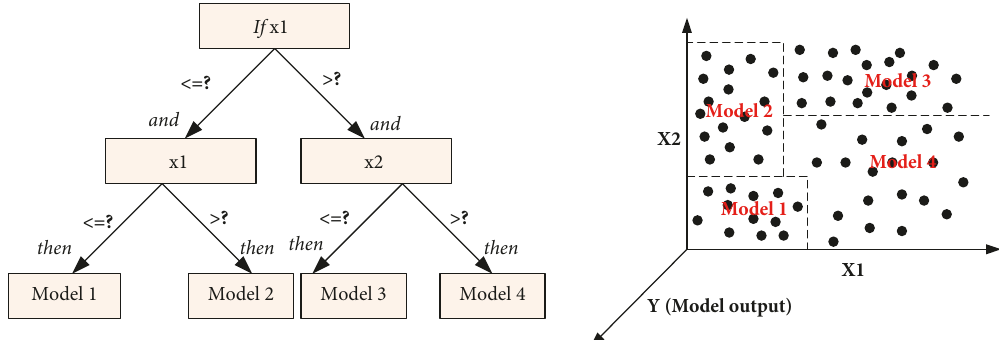
Figure 3: M5Tree, splitting the input space into subspaces and the resultant diagram